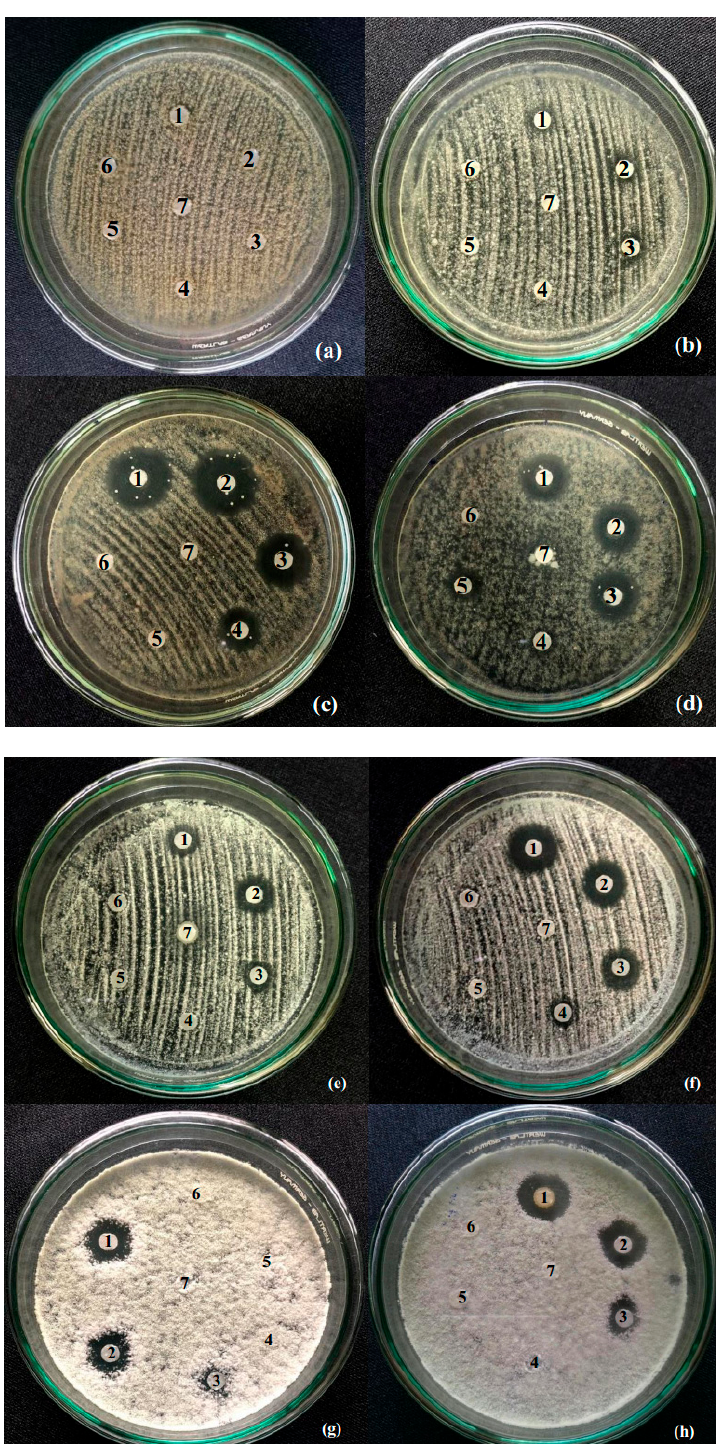
Figure 8. Minimum fungal concentration (MFC) of ( a , b ): Aspergillus flavus NBRC 33021; ( c + d ): Aspergillus niger NBRC 4066; ( e + f ): Aspergillus clavatus NBRC 33020; ( g + h ): Fusarium solani NBRC 31094; disk ( a , c , e , g ): Natamycin and disk ( b , d , f , h ): WRE.